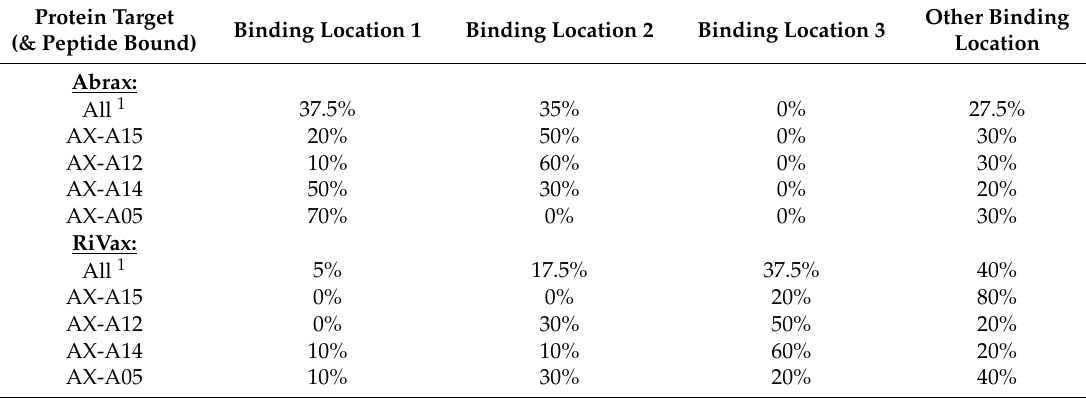
Figure 2. Localization of Tier 1 peptides. ( A ) Front view and ( B ) back view for the overlay of the top 10 decoys, as determined using XPairIt, of the abrax binding peptides A5, A12, A14, and A15 on RiVax (bound peptides: red spheres, protein: cyan ribbons) and abrax (bound peptides: blue spheres, protein: purple ribbons). Note the structural similarity between RiVax and abrax but disparity in predicted binding locations of the peptides. Binding locations 1–3 are numbered. Table 1. Percent of Top Ten Decoys from XPairIt Analysis at Each Binding Location on Abrax or RiVax (Shown in Figure 2) for Tier 1 Peptides A5, A12, A14, and A15.